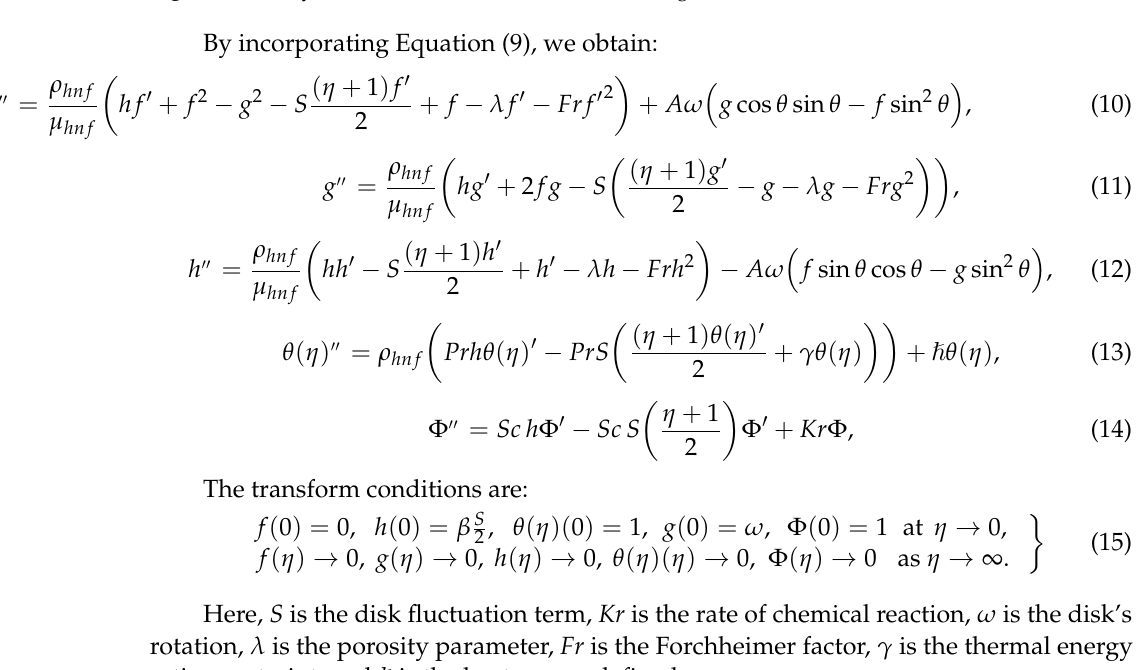
Figure 1. The hybrid nanofluid flow over a fluctuating disk.